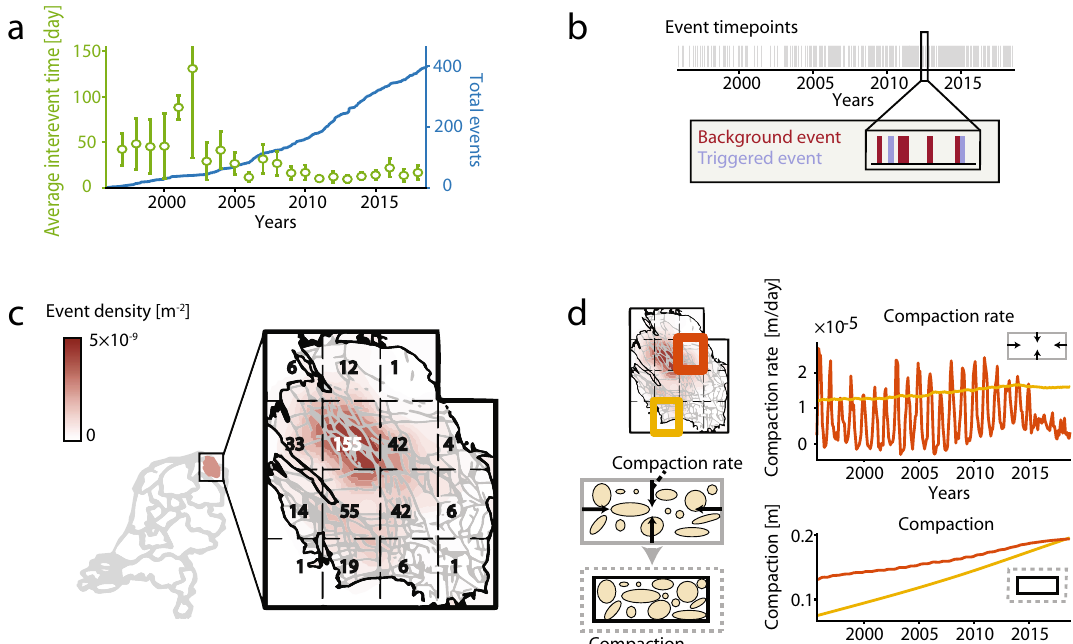
Figure 1. Groningen-field local characteristics and non-stationary induced earthquakes. ( a ) Yearly average interevent time (days) between two subsequent events in the field (green dots) and the evolution of the total number of events (blue line) from October 1995 until October 2018. ( b ) For each event (light grey) it is unknown whether this is a background (red) or a triggered event (purple). ( c ) Schematic overview of the faults (solid grey) in the field and the probability-density map ( m − 2 ) of the induced-earthquake locations in the period 1995–2018 ( M ≥ 1.3 , n = 397 ). The field is divided into 15 grid cells and the total number of events per cell is presented. ( d ) The average compaction rate (m/day) and total compaction (m) of the ground soil over time for the two highlighted regions. For the red region the swing in compaction rate is due to the seasonal swing in gas